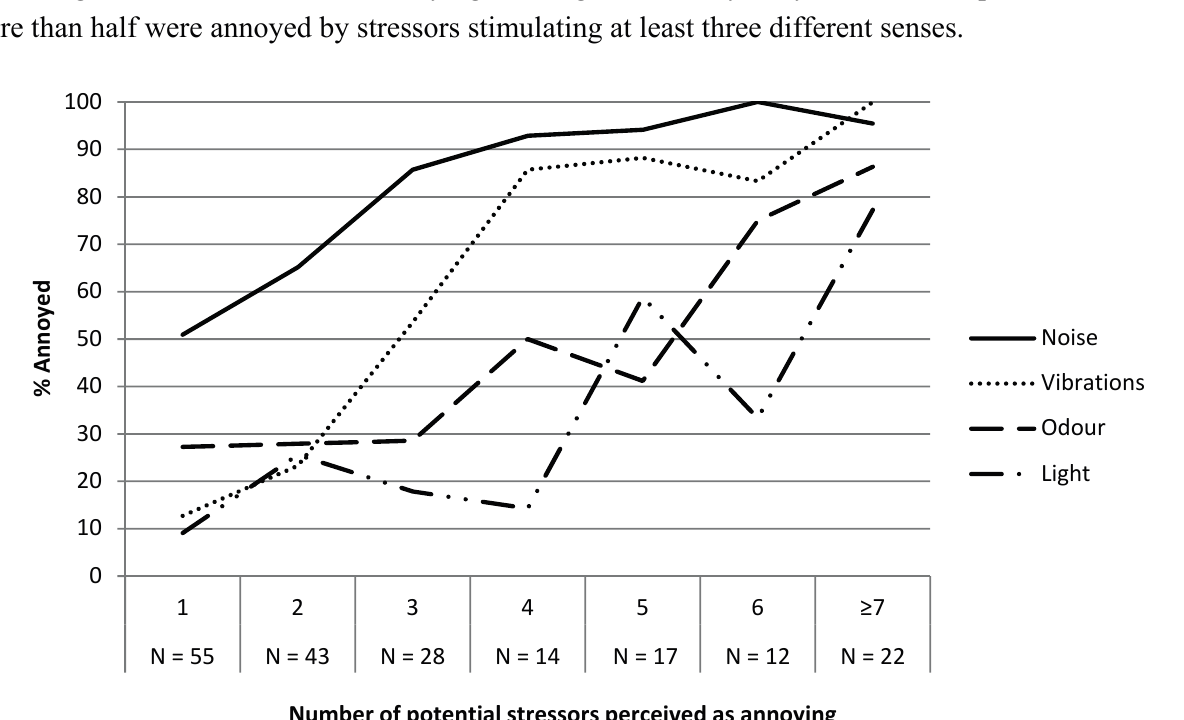
Figure 2. Proportions of respondents annoyed by noise, vibration, odour, and light relative to how many potential stressors they perceived as